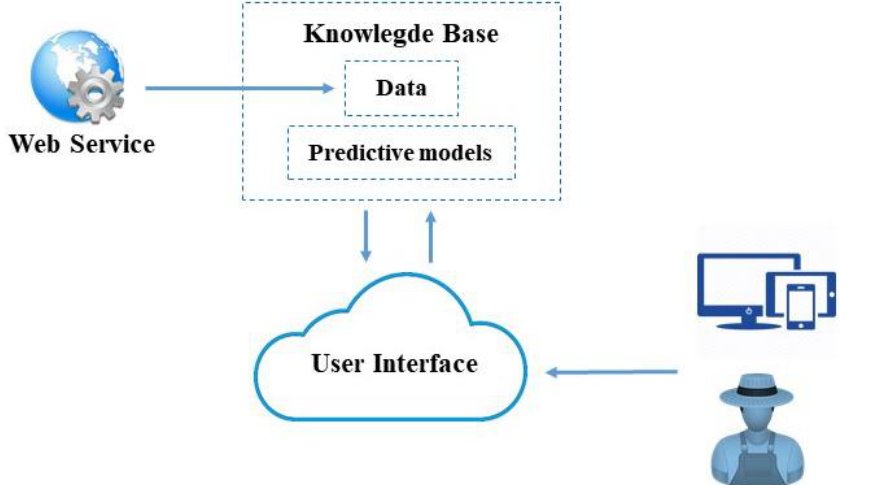
Figure 4. Schematic representation of the web application.